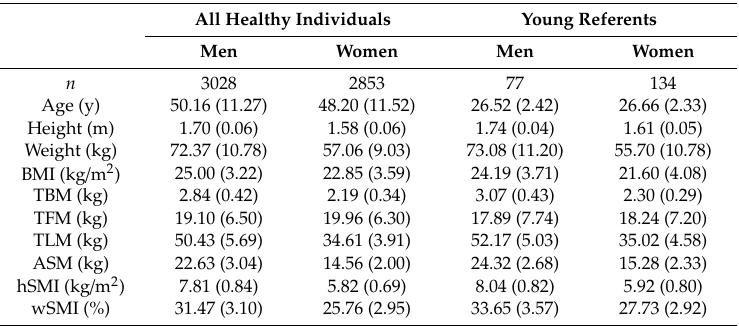
Table 1. Demographic data for the healthy